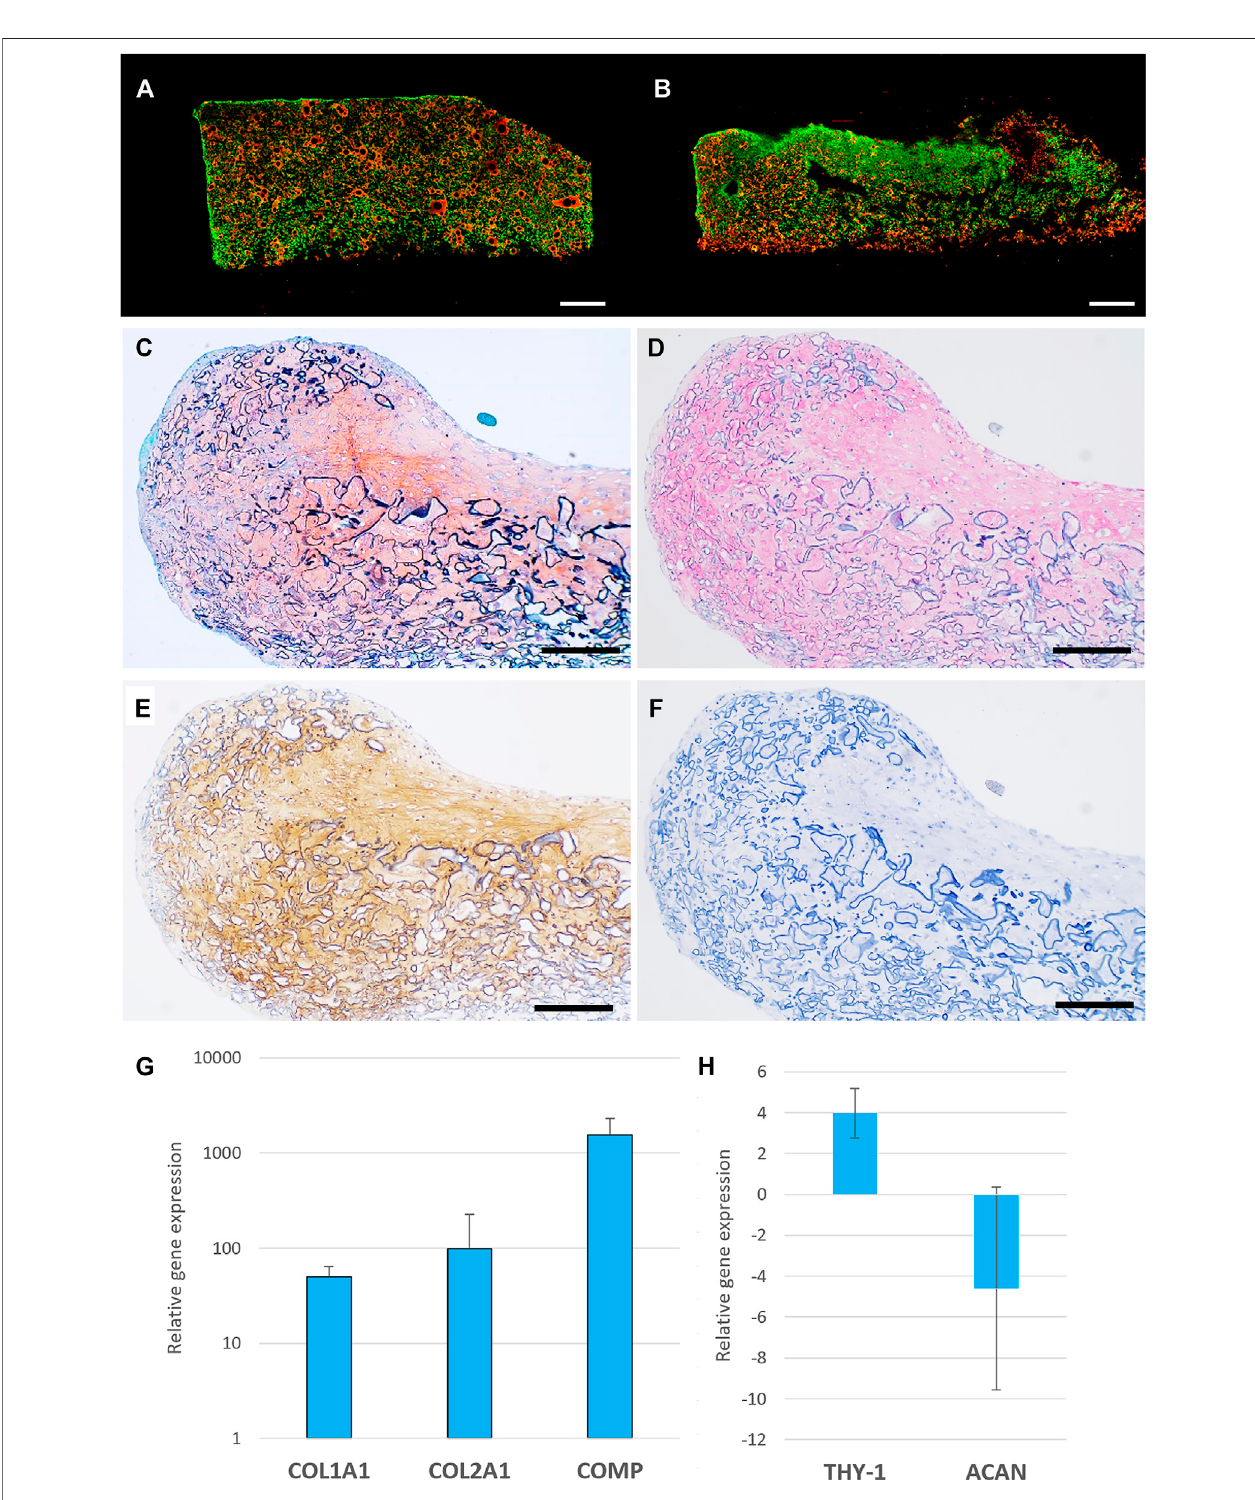
FIGURE 4 | Cell viability, histology and gene expression of IPFP-MSC seeded pneumatospun collagen scaffolds. (A,B) Cell viability of IPFP-MSC seeded collagen scaffolds(livecells =green),dead cells=red,bar =1000 μ m) (C) SafraninOstainofneotissueformed oncollagenscaffold. (D) Collagentype Iimmunostaining (APred). (E) Collagen type II immunostaining (DAB brown). (F) Isotype control immunostaining. (Bar = 200 μ m) (G,H) . Gene expression levels of IPFP-MSC seeded on collagen scaffolds after 3 weeks in serum free medium relative to monolayer undifferentiated cultured IPFP-MSC ( n = 6).